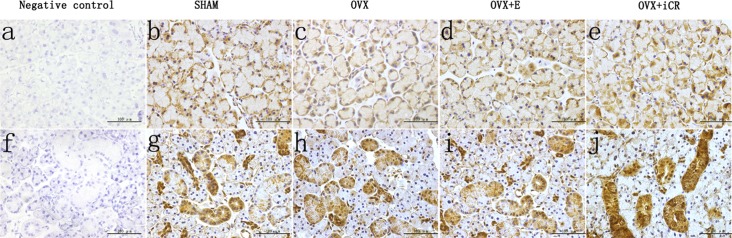
Cu-Zn SOD expression.a-e, lacrimal gland; f-j, submandibular gland. Scale bars represent 100 μm (magnification ×400). In the negative control, no brown precipitation was observed, representing no positive response. In the lacrimal gland, positive staining of Cu-Zn SOD mainly occurred on the basolateral side of the acinar cells, while in the submandibular gland, strong staining was found in the GCT and striated ducts.